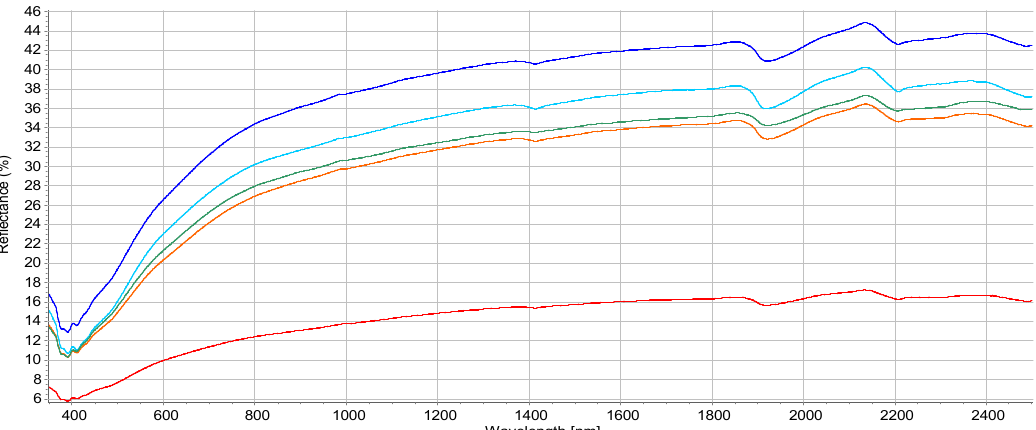
Figure 4. Mean reflectance spectra according to Σ 16PAH content. Blue: class 1 (200–600 µ g kg − 1 ); turquoise: class 2 (600–1000 µ g kg − 1 ); green: class 3 (1000–5000 µ g kg − 1 ); orange: class 4 (5000–10,000 µ g kg − 1 ); red: class 5 ( > 10,000 µ g kg − 1 ).